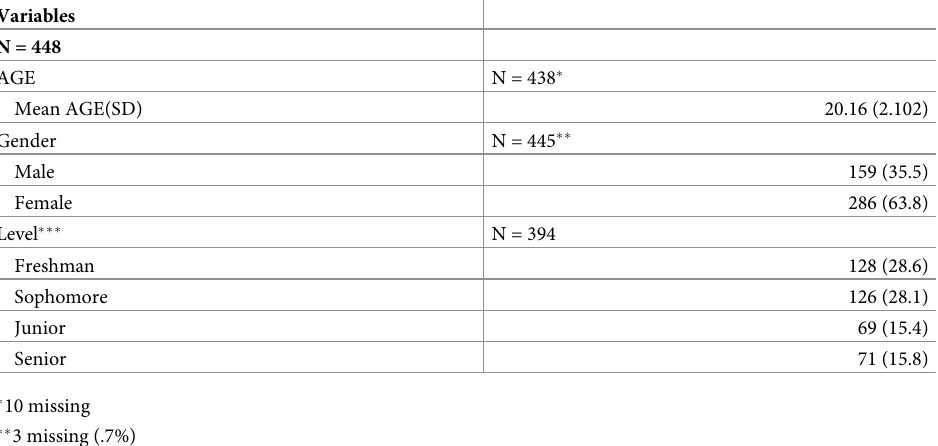
Table 1. Socio-demographic characteristics of the study